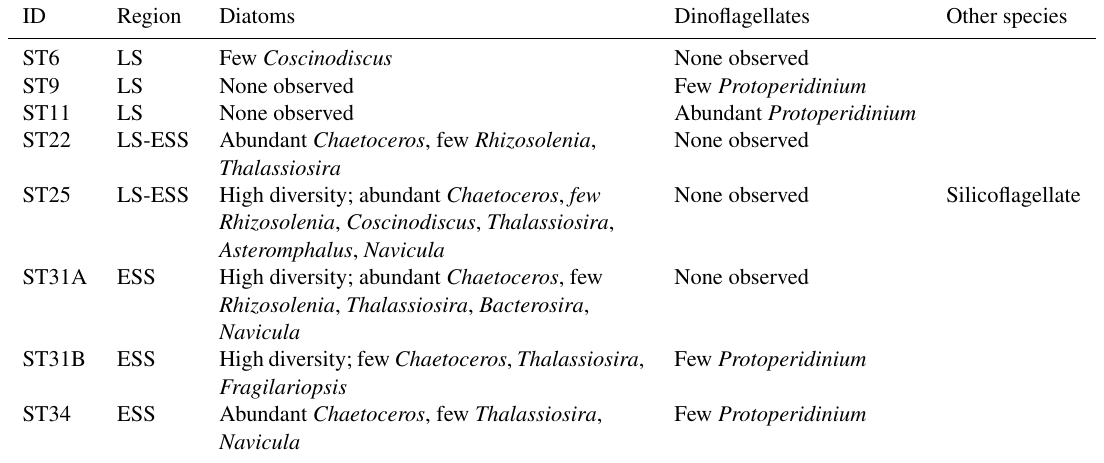
Table 3. Qualitative plankton characterisation of selected POM (>10µm) samples. ID Region Diatoms Dinoflagellates